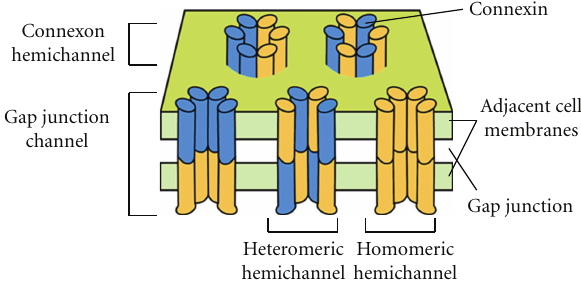
Figure 1: Multiple levels of gap junction channel structure. Individ- ual transmembrane connexins (coloured blue and orange) assemble into hexamers called “connexon hemichannels.” Connexons from two adjacent cells join to make a channel across two plasma membranes (green), forming a “gap junction